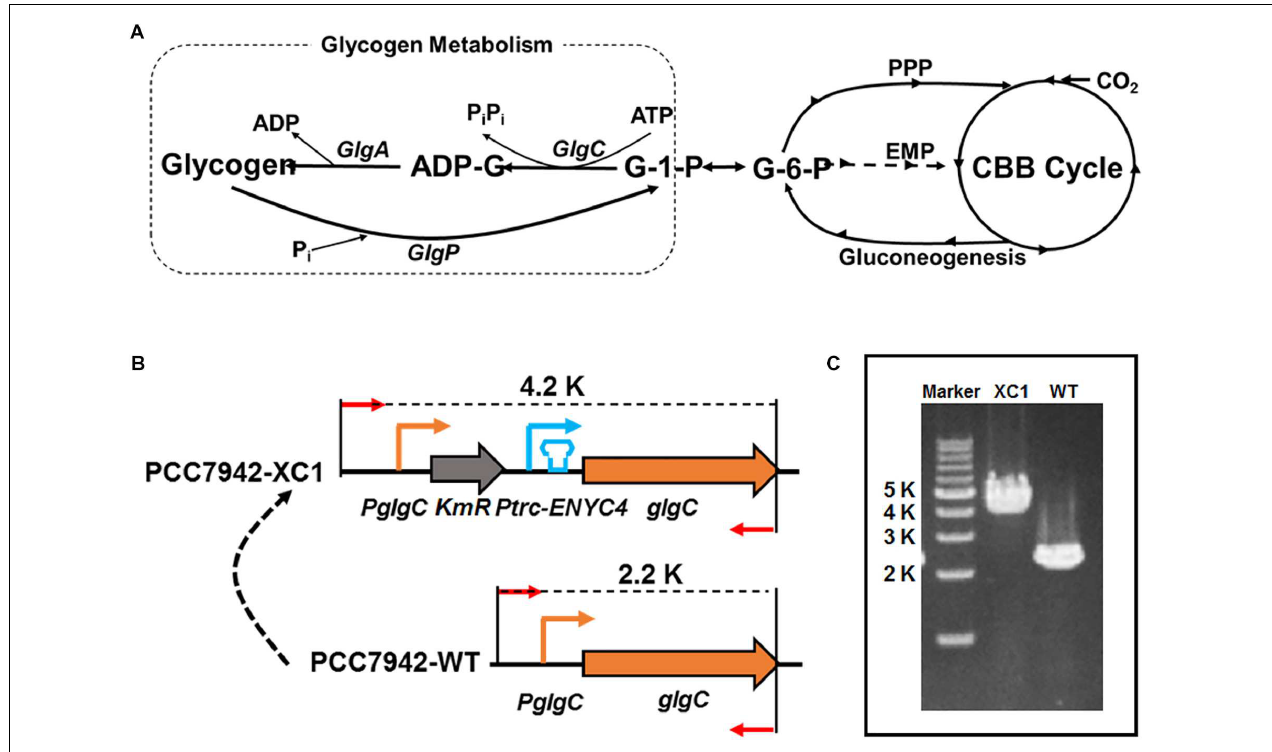
FIGURE 1 | Development of a theophylline-responsive glgC -expression system in Synechococcus elongatus PCC7942. (A) Schematic representation of glycogen metabolism in cyanobacteria. GlgP, glycogen phosphorylase; GlgC, glucose-1-phosphate adenylyltransferase or ADP-glucose pyrophosphorylase; GlgA, glycogen synthase; G-1-P, glucose-1-phosphate; G-6-P, glucose-6-phosphate; ADP-G, ADP-glucose; PPP, pentose phosphate pathway; EMP, Embden-Meyerhof-Parnas pathway, glycolytic pathway; CBB cycle, Calvin-Benson-Bassham cycle; Pi, inorganic phosphate; PiPi, pyrophosphate. (B) Construction strategy of a theophylline-responsive riboswitch control system on glgC expression in PCC7942. KmR , kanamycin resistance gene; PglgC , native promoter sequence of glgC. (C) Genotype identification of the PCC7942-XC1 and PCC7942-WT by